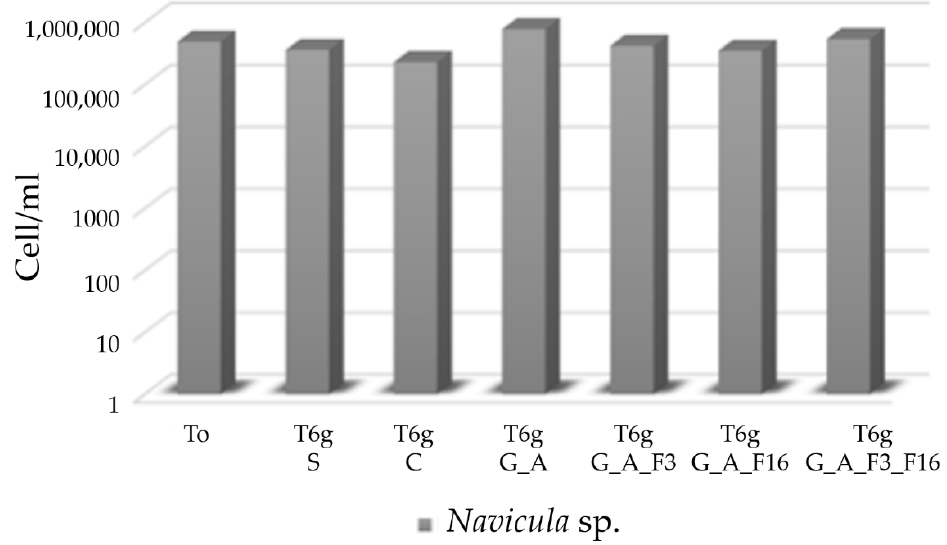
Figure 20. Histogram showing the absence of toxicity against Navicula in contact to untreated and treated glasses as measured through direct count of cells under microscope in Burker counting chamber.